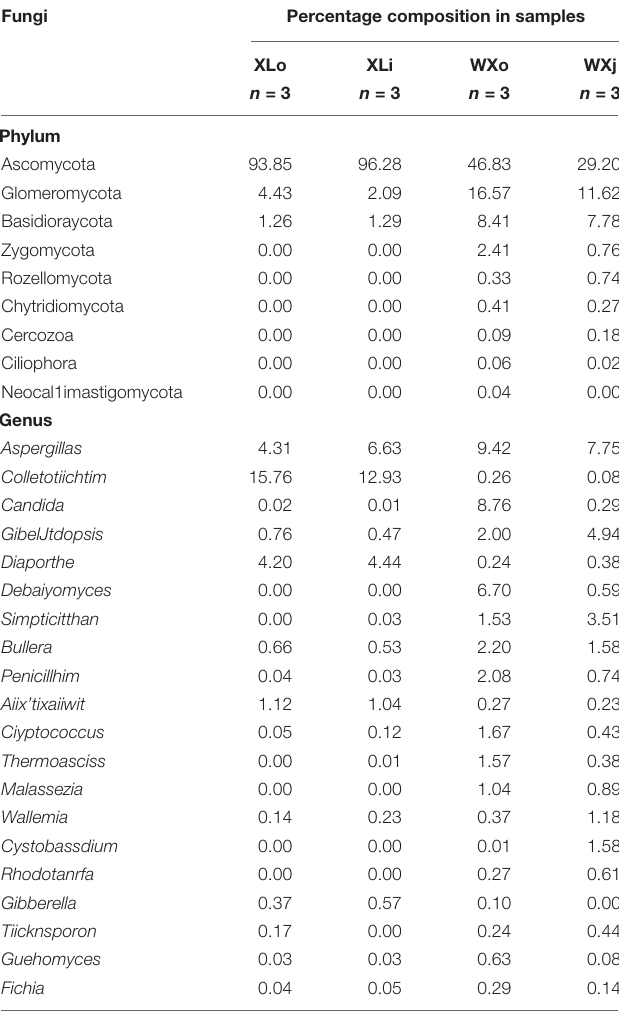
TABLE 4 | Percentage of the main fungal phylum and genera in samples.